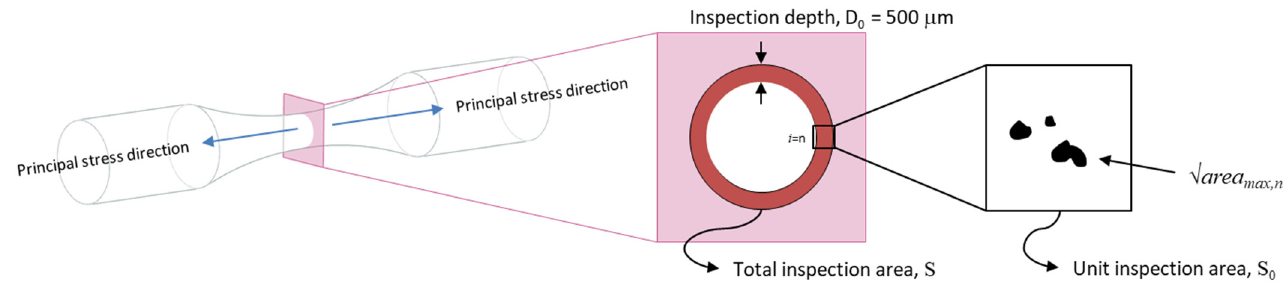
Figure 3. Schematics of inspection areas and assessment of the corresponding inclusion sizes.